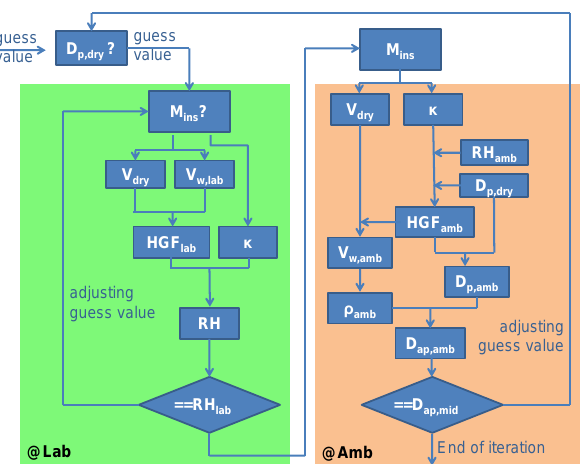
Fig. 1. Sketches of particle composition under different conditions: (a) is for dry particles; (b) is for particles under laboratory con- ditions; (c) and (d) are for particles under ambient conditions. In the former three panels ( a , b , c ), particles are indicated with mo- bility diameters, while in the last panel (d) particles are indicated with aerodynamic diameters. The diameters of particles vary under different conditions due to the variation of equilibrium water. The “identified” represents the summation of all chemically analyzed species such as inorganics, OM and EC. The amounts of identified and unidentified matter remain constant under all conditions.